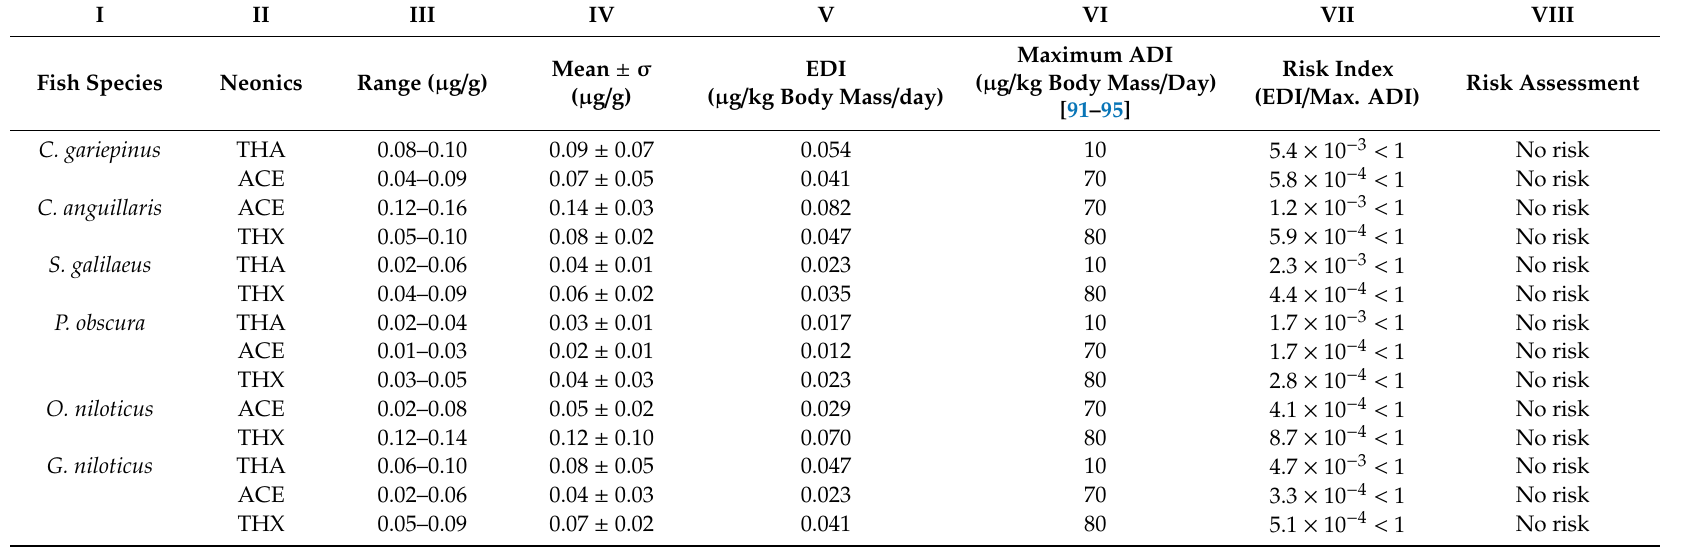
Table 5. Mass concentrations of neonics in six fish species (means and range per individual) and estimated daily intakes (EDI), acceptable daily intakes (ADI) and